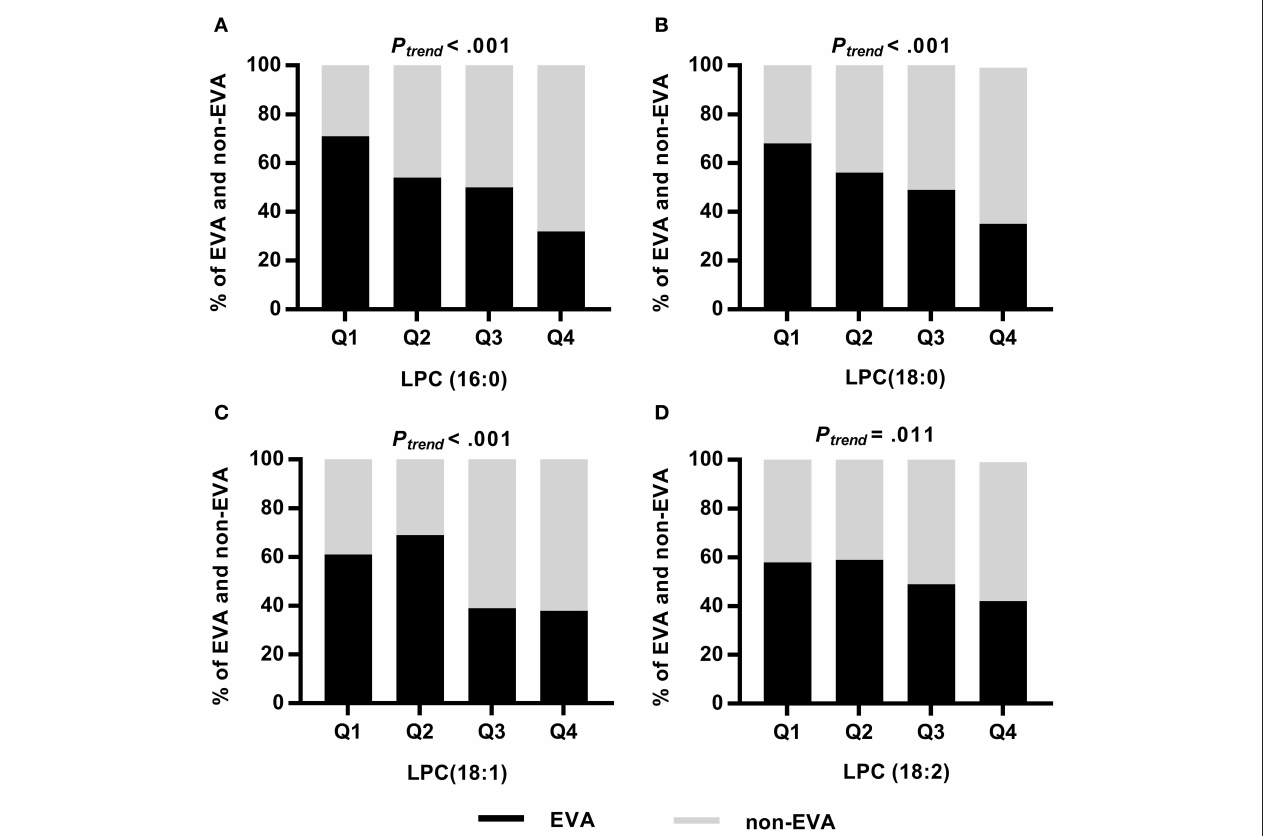
FIGURE 2 | Frequency of EVA and non-EVA individuals across quartiles of a given LPC: LPC (16:0) (A) , LPC (18:0) (B) , LPC (18:1) (C) , and LPC (18:2) (D) . P -values were calculated by Chi square test for trend.